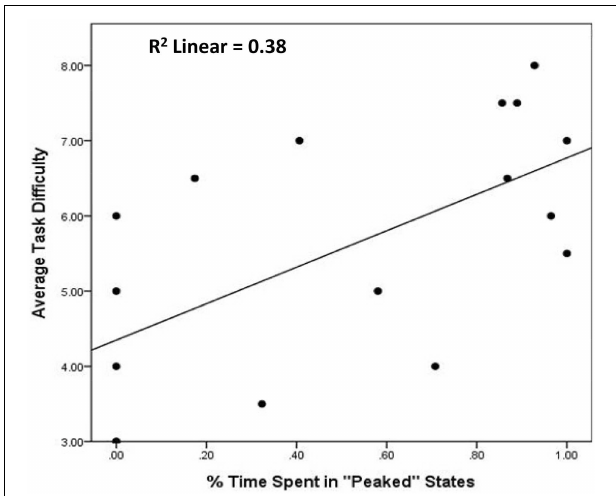
FIGURE 10 | Association between average time spent in peaked states and self-reported task difficulty. Illustrates that BP-HMM modeling output can be reduced to metrics with intuitive and predictive utility. First, metrics describing the structure of states have bearing on users’ understanding of how game interface functions are integrated. Second, participants who rely on specific functions, without exploring (or trying to discover) other ways of interacting with the game interface report difficulty with the game task